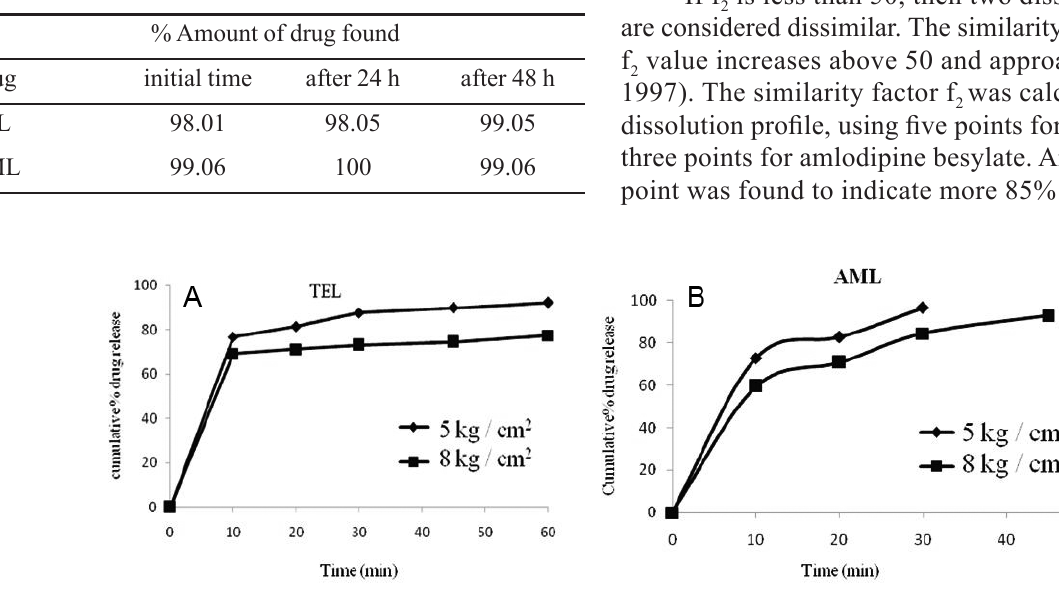
FIGURE 4 - Comparison of dissolution profiles of TEL/AML tablets manufactured with different hardness.(A) Profile for TEL and (B) for AML.